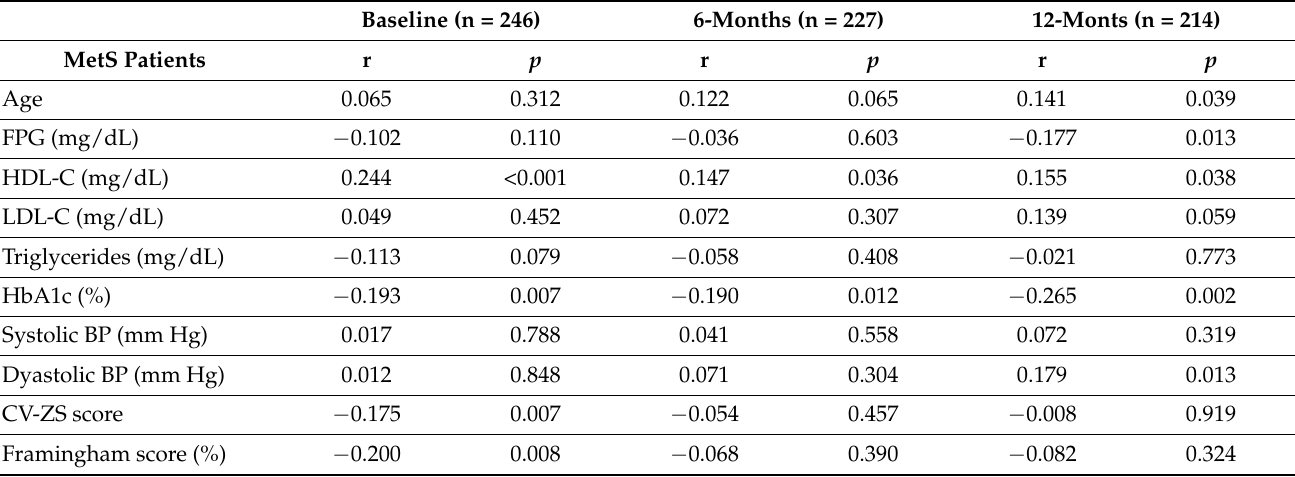
Table 3. Variables correlated with serum ucOC levels (log) at baseline, at 6 and 12 month follow-up. Baseline (n =